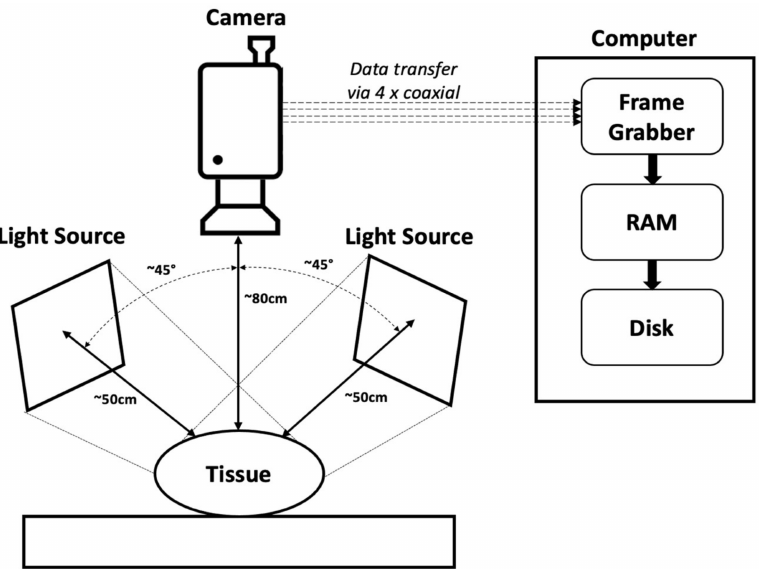
Figure 3. Acquisition setup, with the tissue supported by a surface and illuminated by two light sources. The camera acquires the data from above the tissue, transfers the video data via coaxial cables to the frame grabber within the acquisition computer, and then directly to the RAM. Once the video data collection is complete, the data is transferred to the disk.